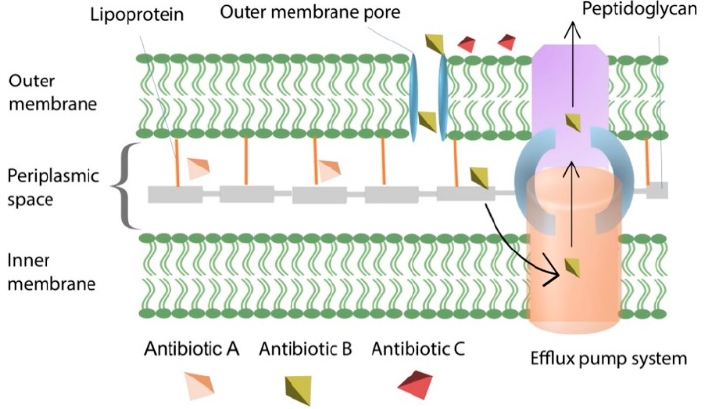
Figure 3. Active efflux pumping system to eliminate antibiotics from the periplasm. Efflux pump is associated with intrinsic antibiotic resistance. Intrinsic resistance is considered as phenotypic resistance as tolerance is not mediated by any genetic mutation. A = beta-lactam antibiotic which binds to the penicillin binding protein (PBP) and destabilizes peptidoglycan; B = aminoglycoside antibiotic; C = polymyxin antibiotic. Most notably, decreased susceptibility mediated by efflux system is mostly linked with aminoglycosides and fluoroquinolone, which is predominantly observed in Gram-negative